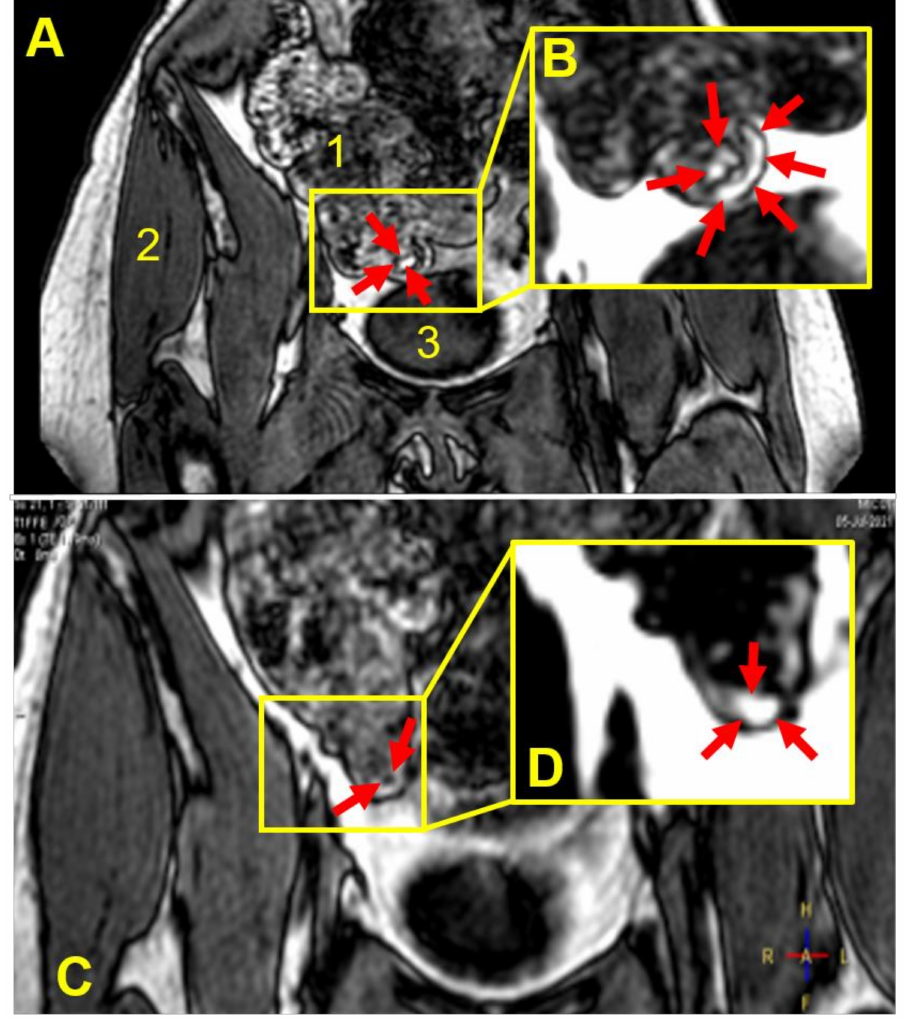
Figure 4. Coronal, fat and water out of phase MRI images of the abdomen of participant number 5 acquired 135 min ( A ) and 180 min ( C ) after consumption of the coated capsule with 240 mL of water. Anatomical landmarks are indicated by numbered labels: ascending colon/caecum ( 1 ), gluteus medius muscle ( 2 ) and bladder ( 3 ). The filled capsule appears bright and is located in the cecum/ascending colon of the large intestine and appeared to be deformed and partially filled ( A ), the capsule being indicated by the red arrows inside the yellow box. The corresponding fat only image (inset ( B )) captured oil leaks out of the capsule into the colon, indicated by the red arrows. At the later time point ( C ), the capsule, indicated by the red arrows inside the yellow box, appeared to have emptied further and provided some water signal component as well, possibly due to hydration/mixing. The corresponding fat only image (inset ( D )) captured a cloud of oil filling that leaked out of the capsule into the colon, indicated by the red